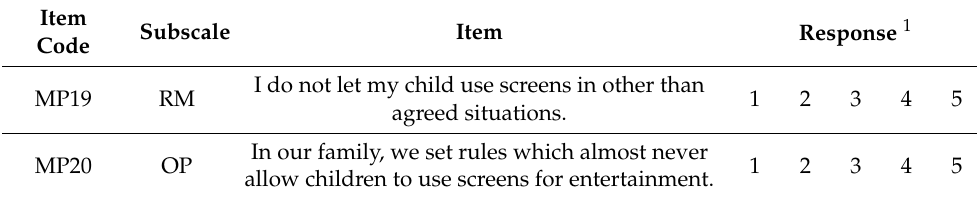
Table A4. Cont. Item Subscale Item Code MP19 RM In our family, we set rules which almost never allow children to use screens for entertainment.